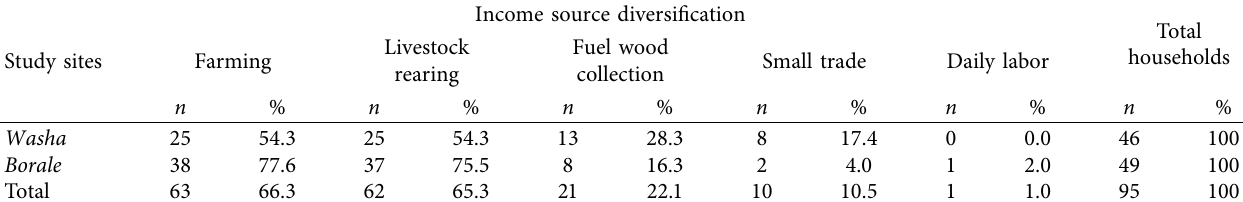
Table 4: Major income source diversification based on the household survey in the study area. Study